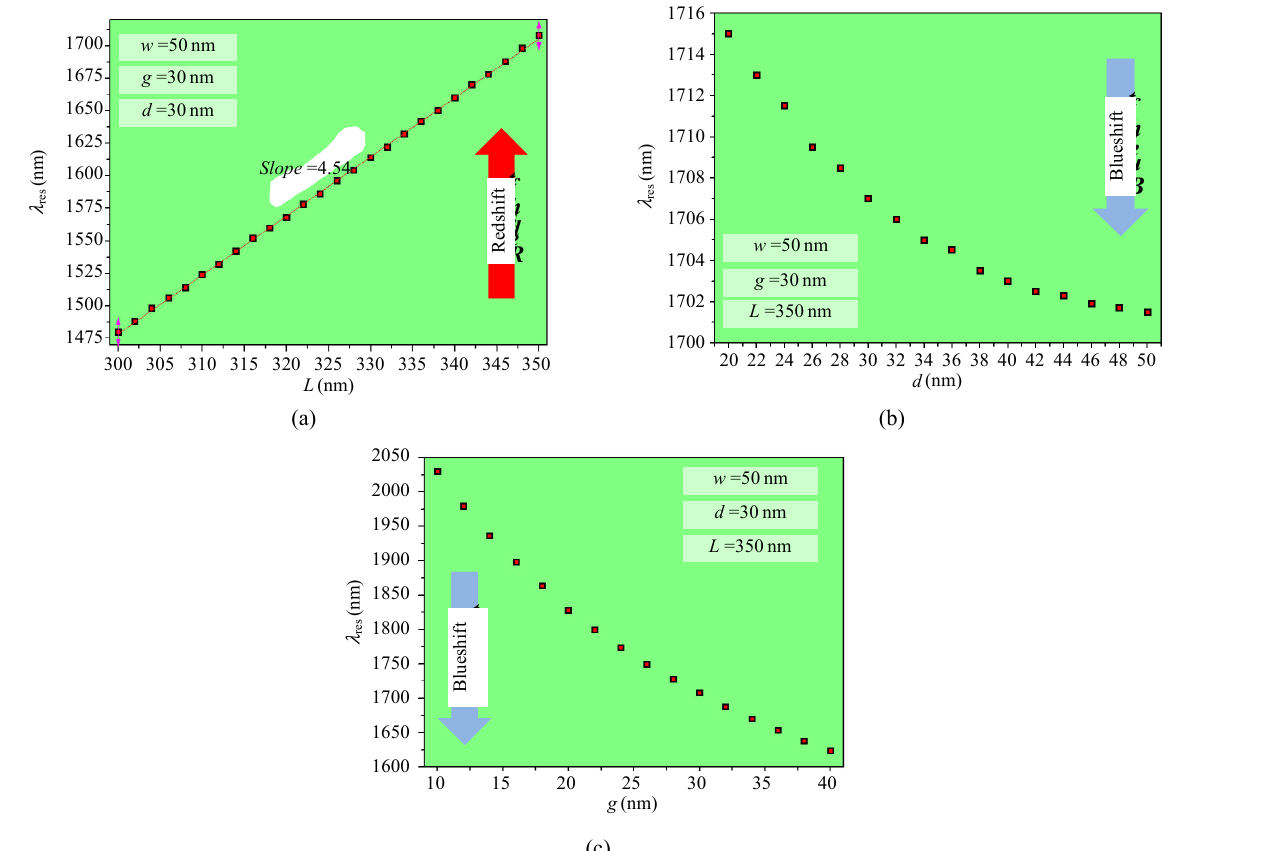
Fig. 2 Dependence of the resonance wavelength on (a) BT length, (b) separation between the bus WG and BT resonator, and (c) BT cavity